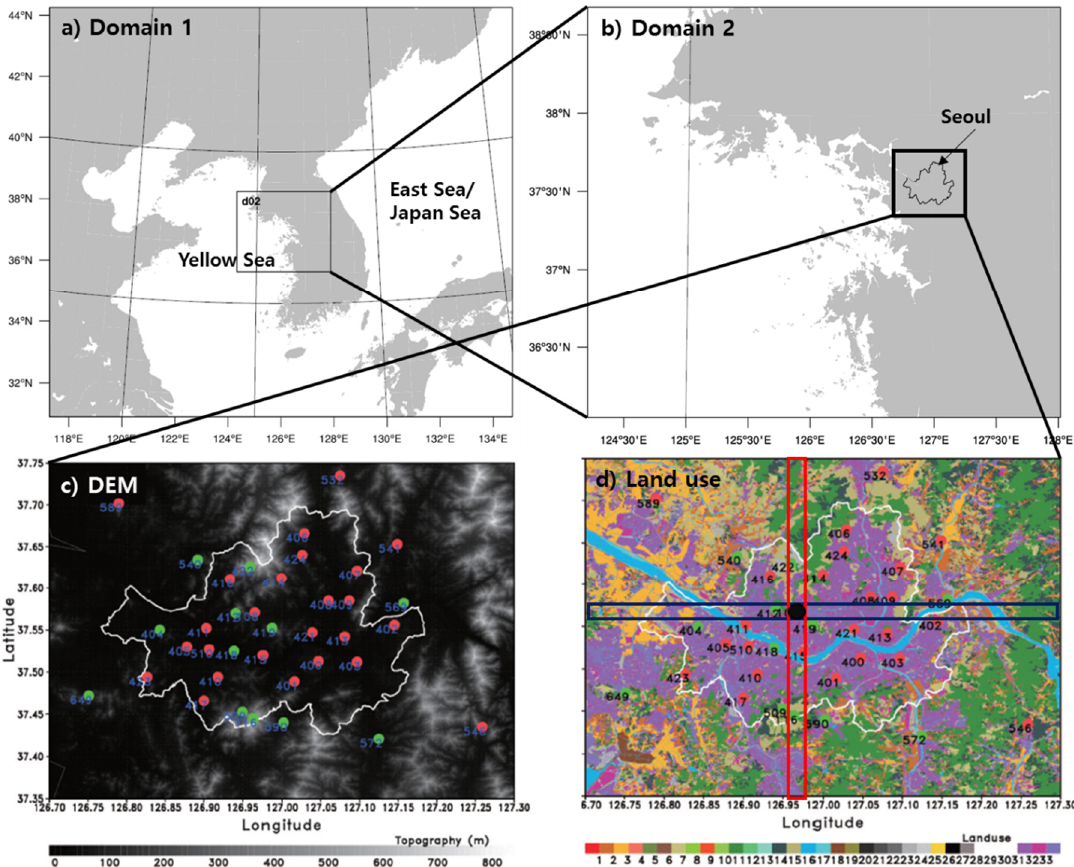
Figure 1. Model domains for ( a ) the outer domain of 5 km; ( b ) the inner domain of 1km (rectangular box in Figure 1a); ( c ) the digital elevation model (DEM); and ( d ) the land use in Seoul and its metropolitan areas. Red dots and green dots in ( c , d ) represent AWS sites in urban and rural areas, respectively. The black dot in ( d ) indicates the Seoul meteorological station (37.57°N latitude, 126.97°E longitude).